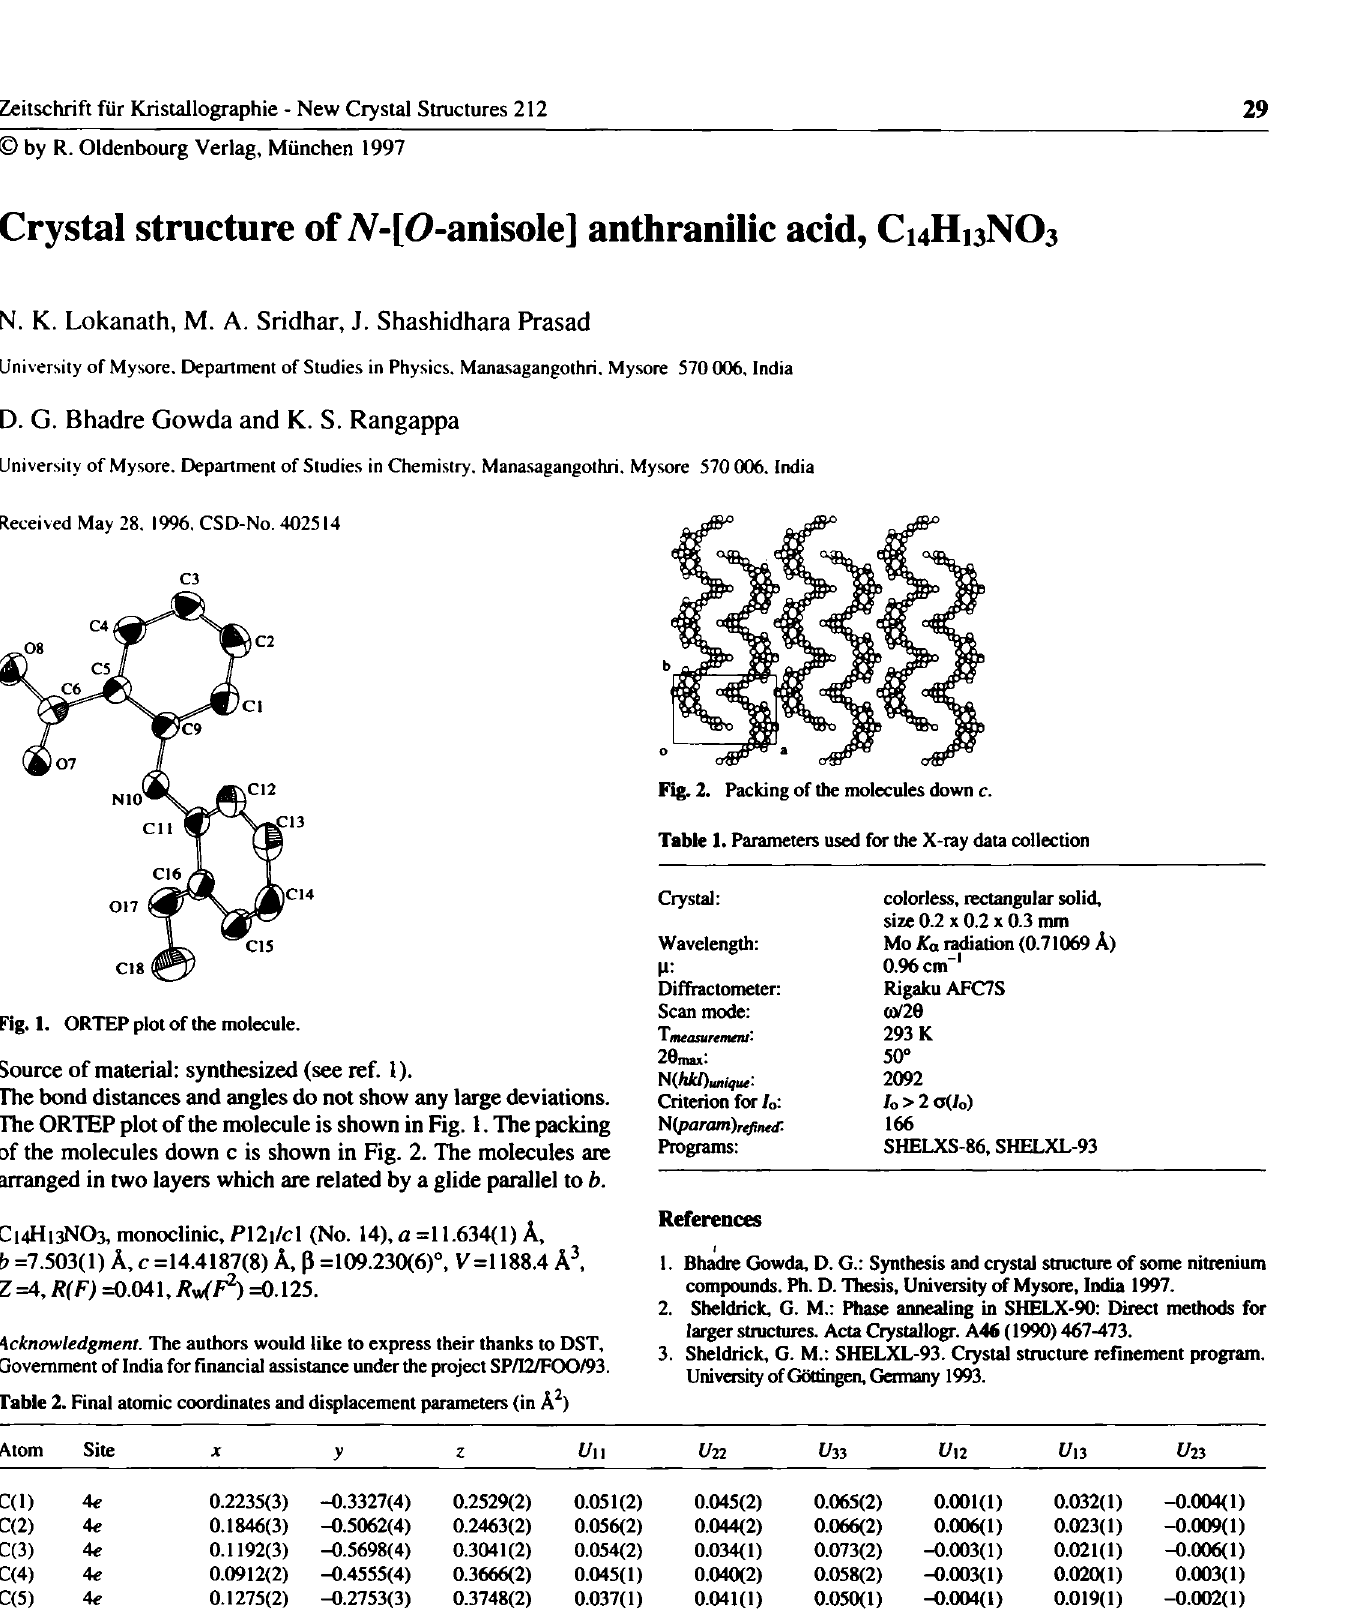
Table 2. Final atomic coordinates and displacement parameters (in À 2 )